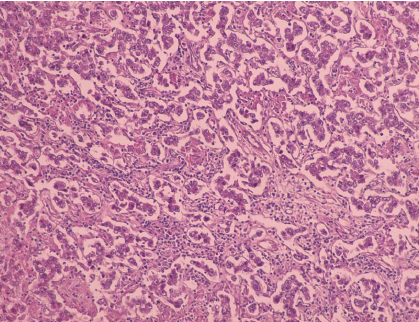
Figure 6: Lymph node metastasis with area of the tumor cells partially replacing the lymph node structure ( × 2.5; H&E